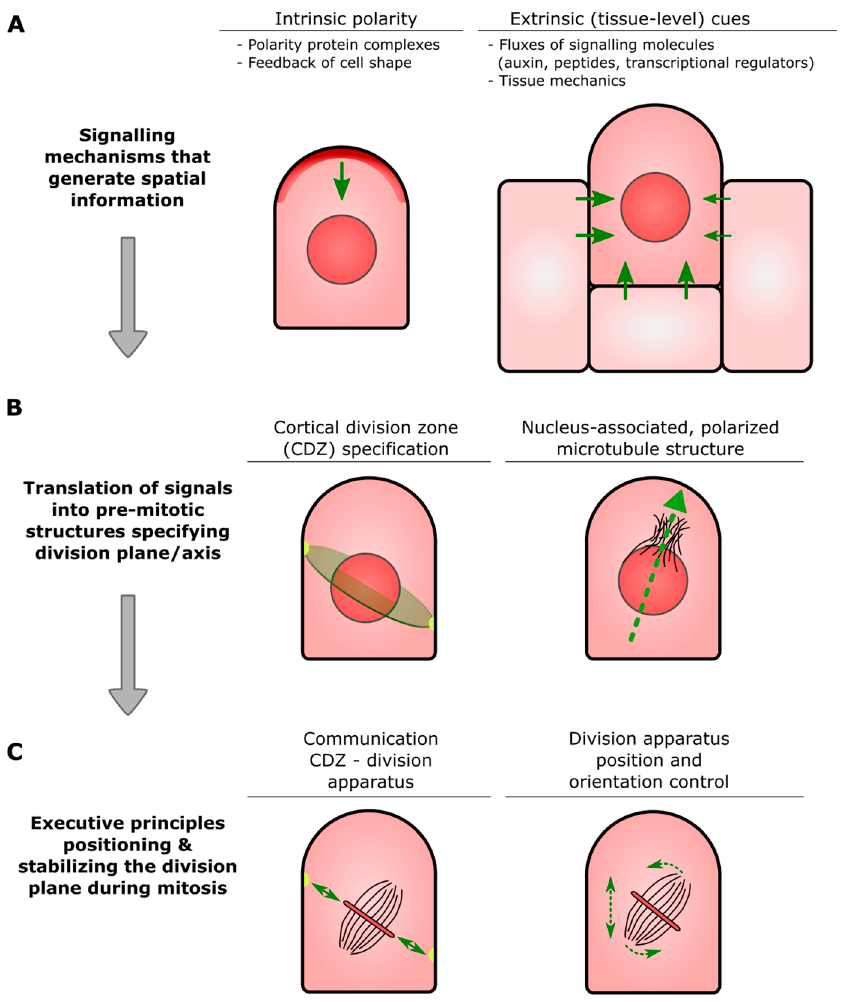
Figure 1. Generalized schematic representation of the processes and factors necessary for correct positioning of division planes during (asymmetrical) plant cell division. ( A ) For a parental cell to polarize, positional information is required. Positional information is generated by both cell-intrinsic factors (left) and extrinsic factors from surrounding tissues (right). Cell-intrinsic factors chiefly act at the cell cortex, where they can establish polarized signaling domains (red). Extrinsic signaling occurs via (unequal) exposure to cues, examples of which are provided. ( B ) As the parental cell is about to undergo mitosis, specific structures arise that will instruct the prospective division apparatus on the position and orientation of the desired division plane. The most prominent structure is the cortical division zone (CDZ; light green) that marks the partitioning plane (left). Additionally, polarized microtubule structures that are associated with the nucleus affect the axis along which division will take place (right). ( C ) As mitosis is executed, continuous control over the position and orientation of the division apparatus is required for proper division plane control (right). Final guidance of the division apparatus constructing the nascent dividing wall towards the CDZ is achieved by physical and/or biochemical communication between these two structures